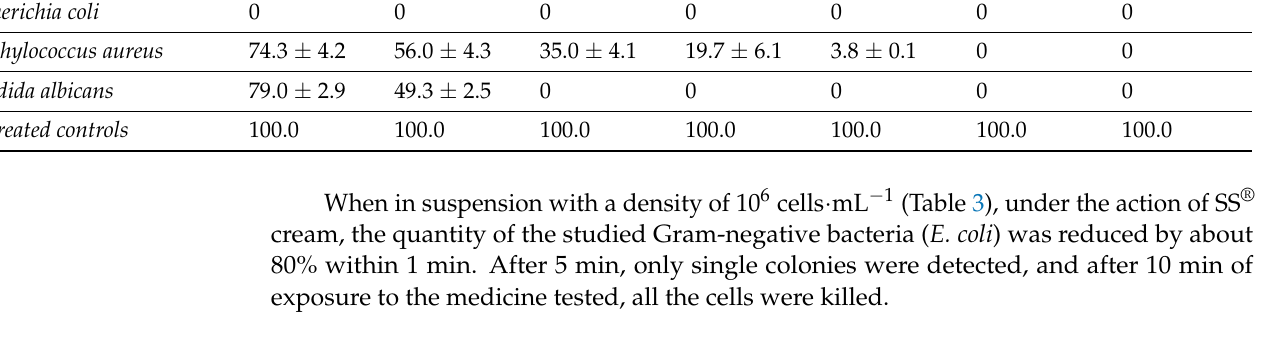
Table 3. Antimicrobial effect of SS ® cream on Gram-positive and Gram-negative microorganisms in suspensions with a density 10 6 cells · mL − 1